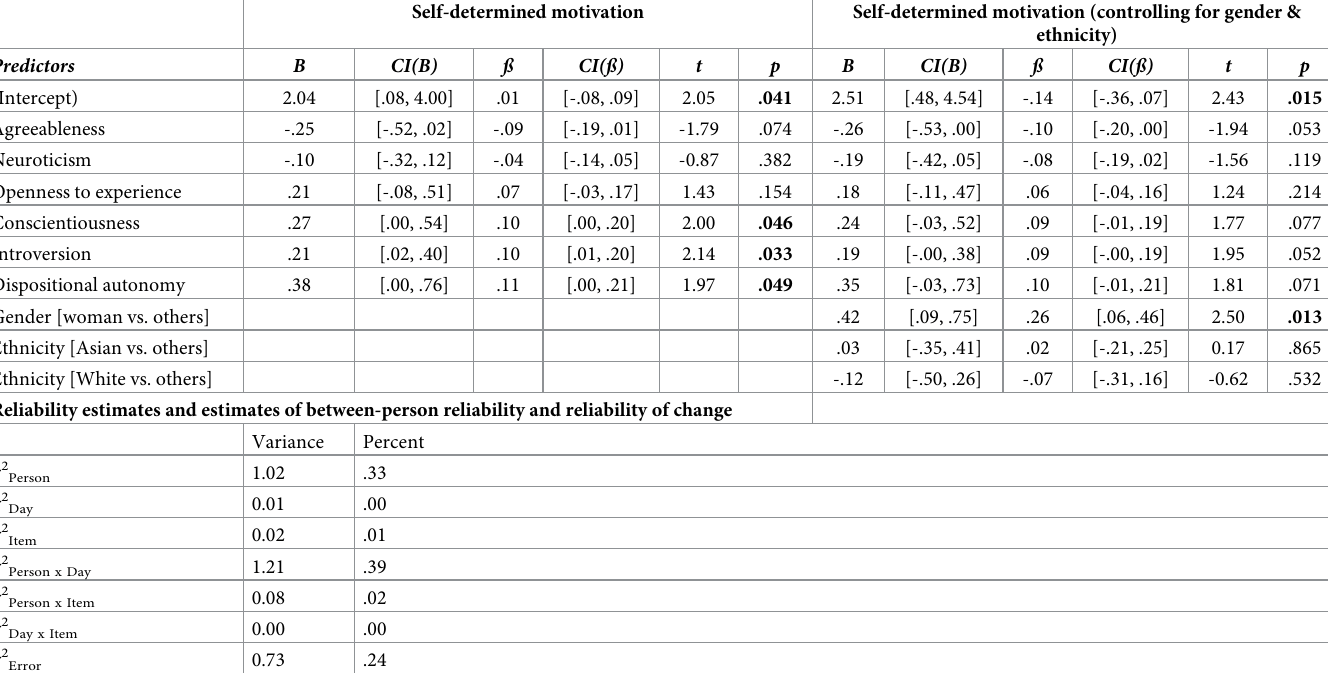
Table 3. Random-intercept models that include introversion, dispositional autonomy, and all other big-five traits, predicting daily self-determined motivation for solitude (Study